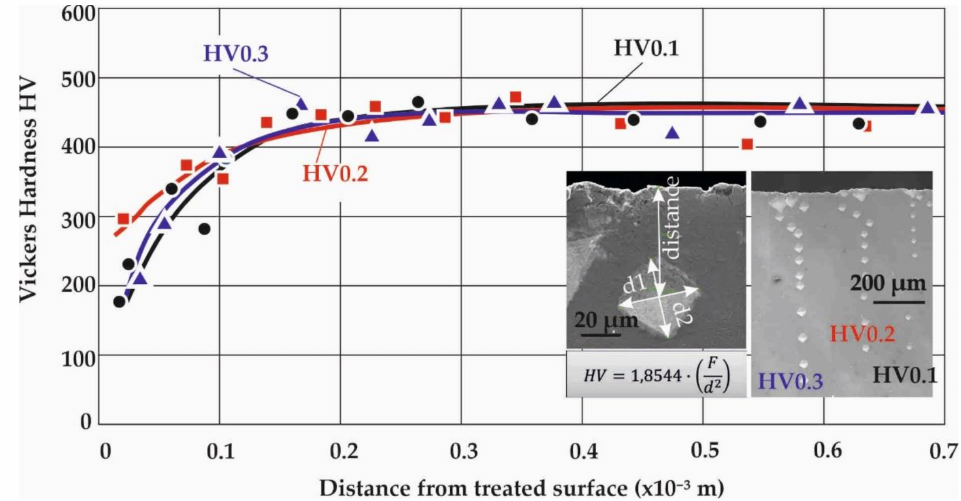
Figure 6. Comparison of Vickers hardness distribution over the distance from the surface, measured after applying 0.1, 0.2 and 0.3 kgf (indentation time 15 sec); exemplary study on an HTT